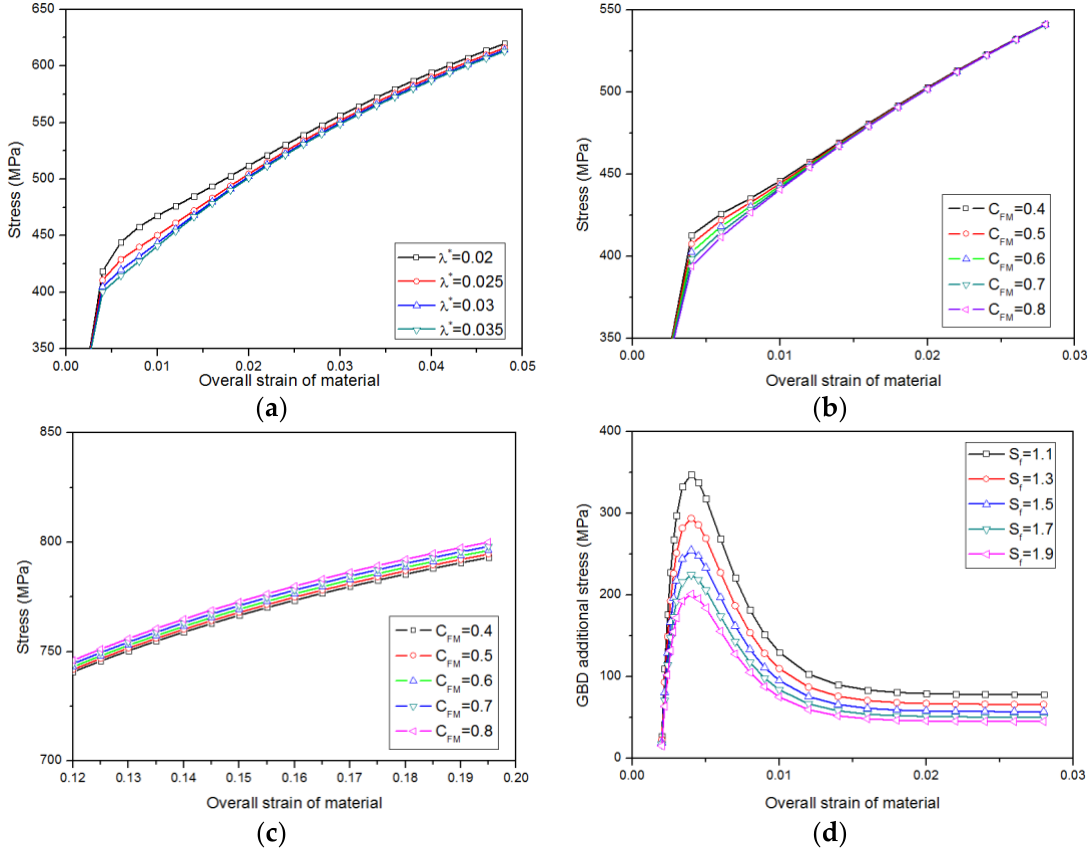
Figure 13. Effects of the minimal GBD spacing effect, FMB percent and ferrite grain shape effect on true stress-strain of DP steel: ( a ) minimal GBD spacing, ( b ) FMB percent effect in small strain, ( c ) FMB percent effect in large strain, ( d ) ferrite grain shape.